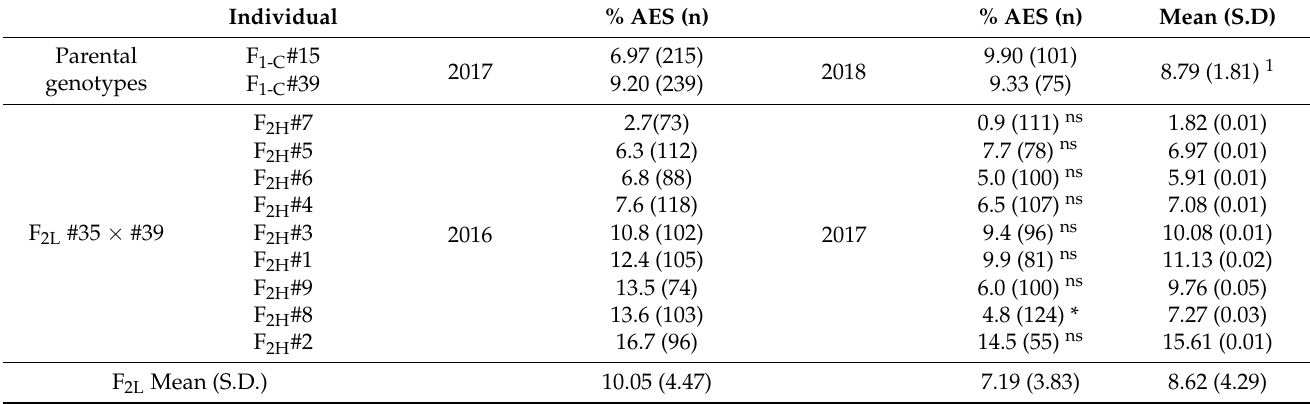
Table 3. Apospory expressivity of parental genotypes and F 2H (#15 × #39) progeny.